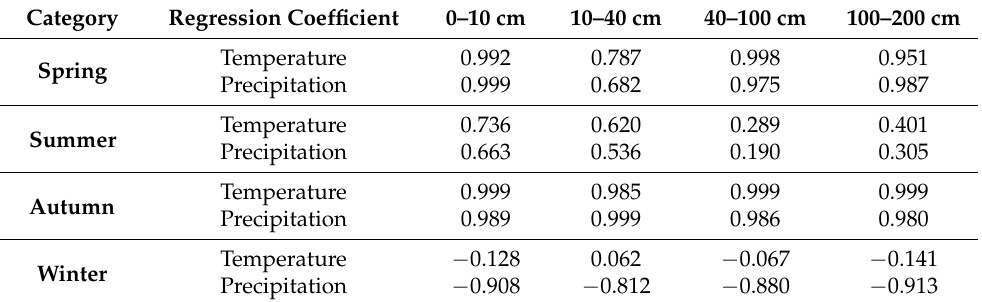
Table 3. Regression coefficients of temperature, precipitation, and soil depth in different seasons.